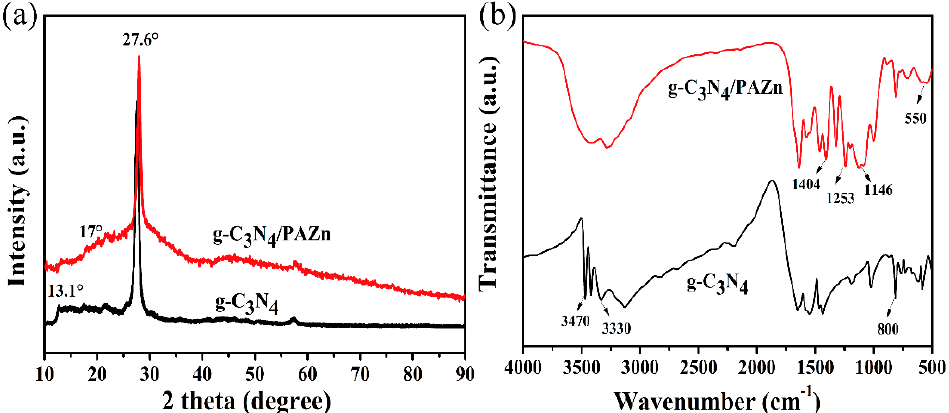
Figure 1. XRD patterns of g-C 3 N 4 and g-C 3 N 4 / PAZn ( a ) and FTIR spectra of g-C 3 N 4 and g-C 3 N 4 / PAZn ( b ).